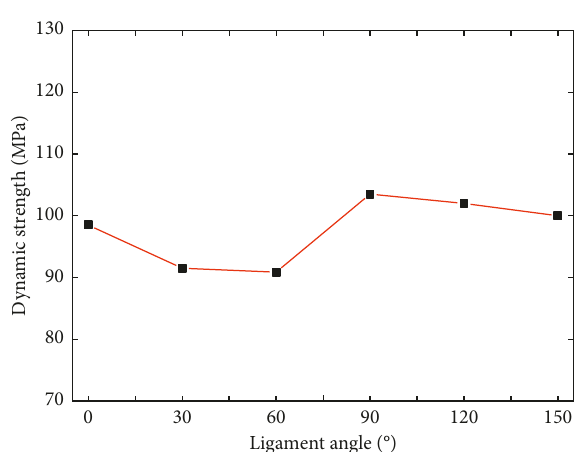
Figure 10: Influence of the ligament angle on the dynamic strength of specimens with a constant flaw angle of 0 ° .